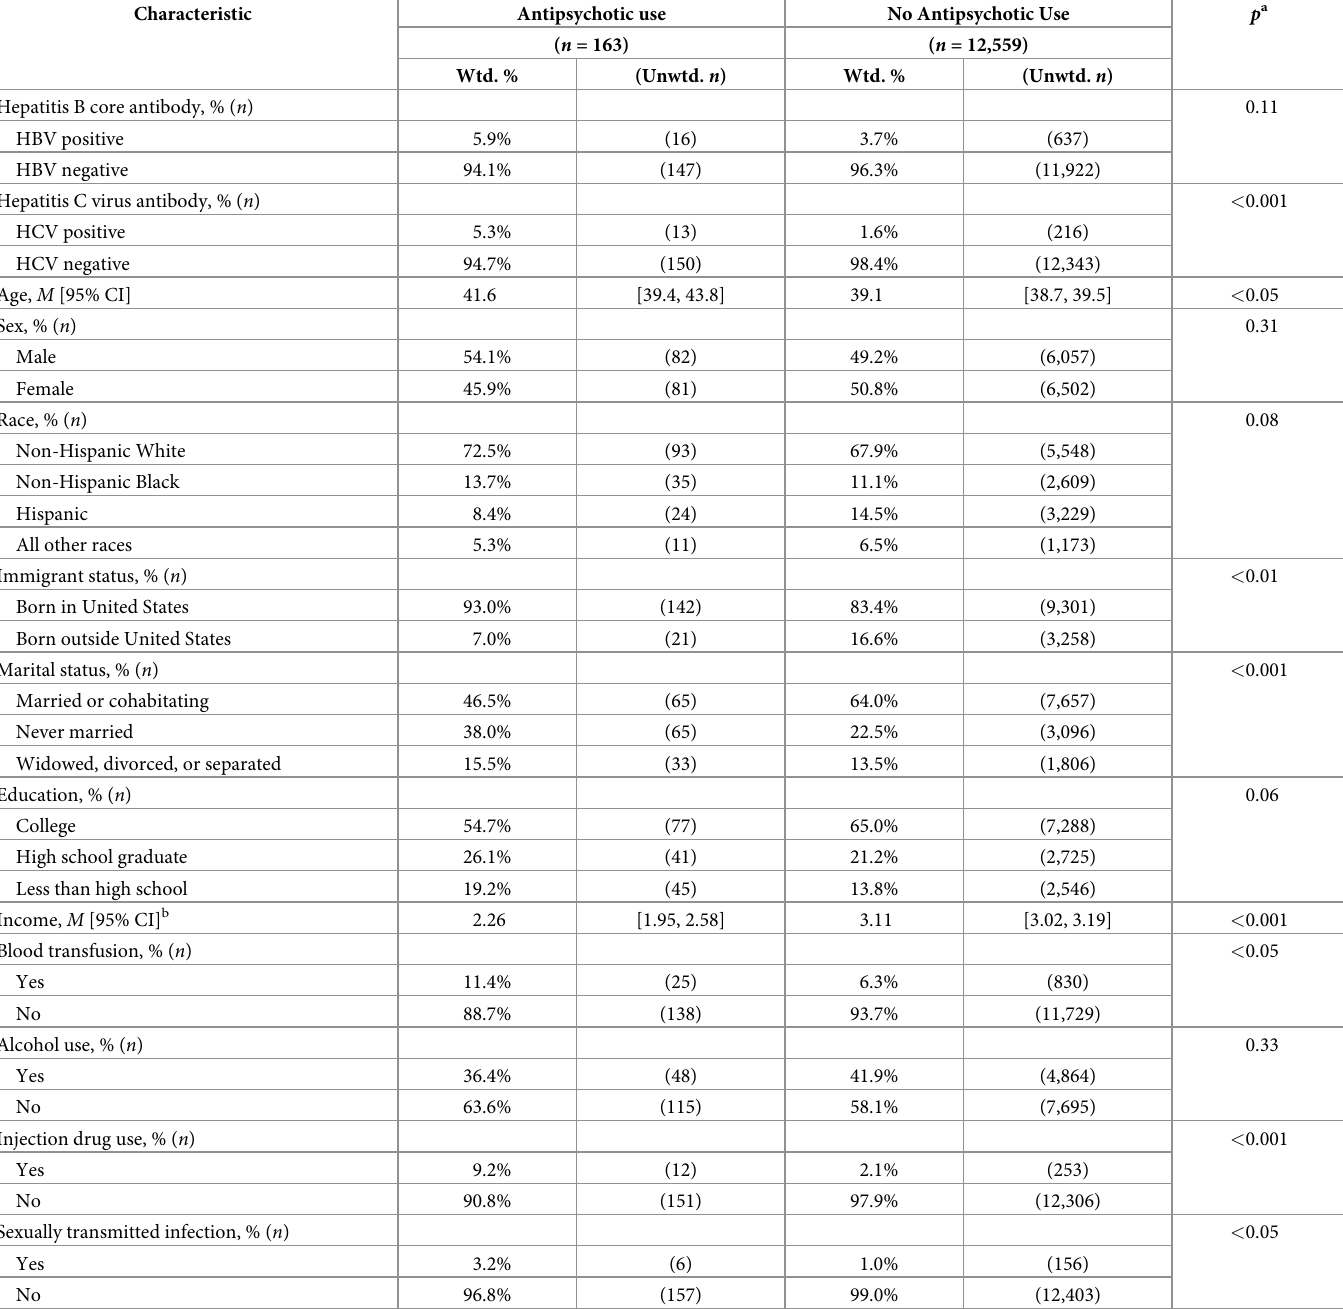
Table 1. Distribution of hepatitis B and C seroprevalence, sociodemographic, and behavioral characteristics by antipsychotic medication use from the 2005–2014 National Health and Nutrition Examination Survey ( n =